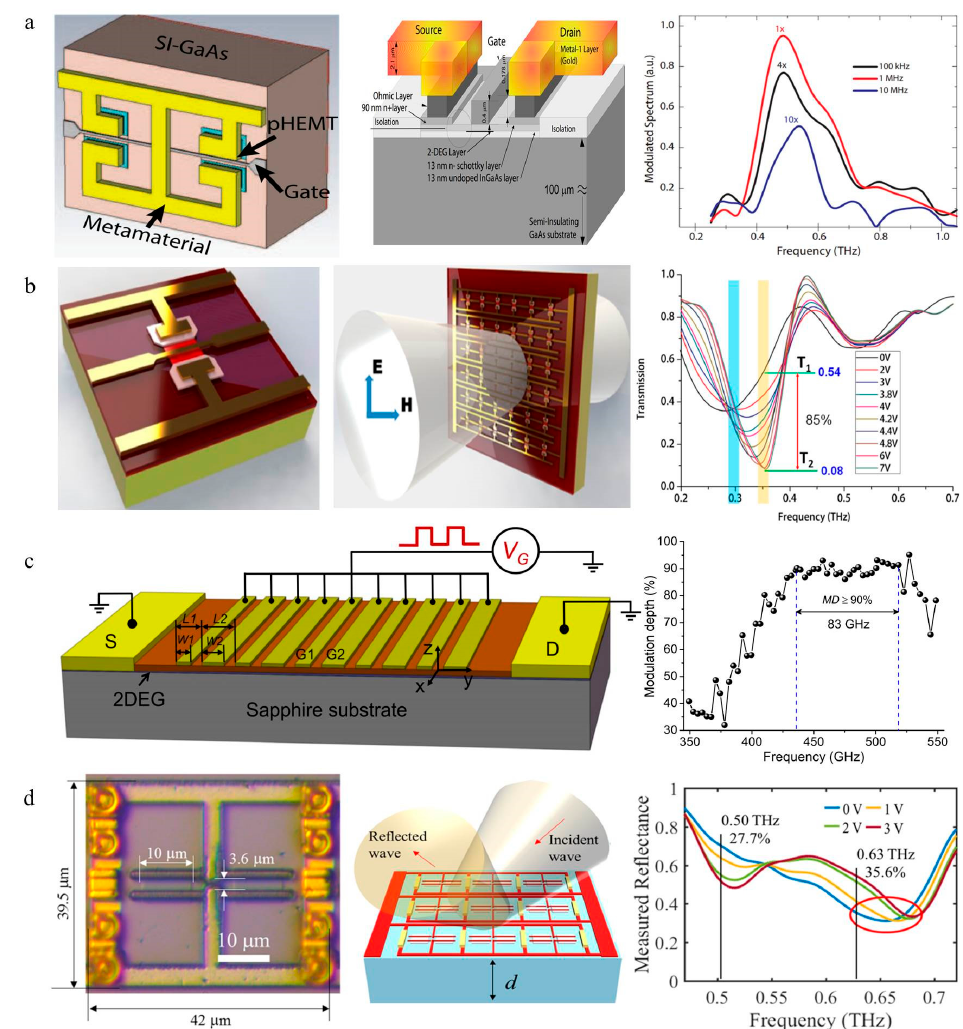
Figure 9. ( a ) A unit cell of the high electron mobility transistor (HEMT)/metamaterial device. The modulation speed of this device is up to 10 MHz. Reproduced with permission from [78]. ( b ) A unit cell of the modulator that utilizes voltage to convert di ff erent dipolar resonances. The transmission of the device at di ff erent voltages. Reproduced with permission from [14], copyright American Chemical Society, 2015. ( c ) Three-dimensional schematic view of the plasmonic terahertz modulator and modulation depth at di ff erent voltages [79], copyright AIP Publishing, 2016. ( d ) Schematic view of the modulator. The figure on the right shows the measured reflectance characteristics of this metasurface. Reproduced with permission from [80].